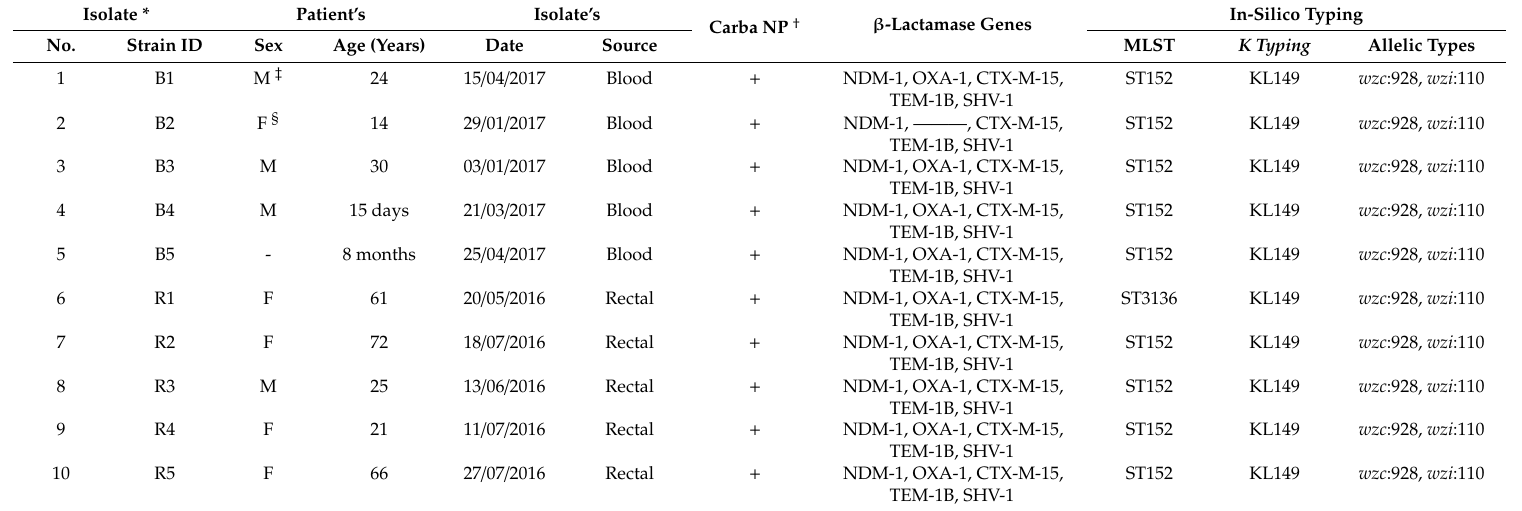
Table 2. Relevant patient data, source of specimens, phenotypic, and genotypic characteristics of CRKP